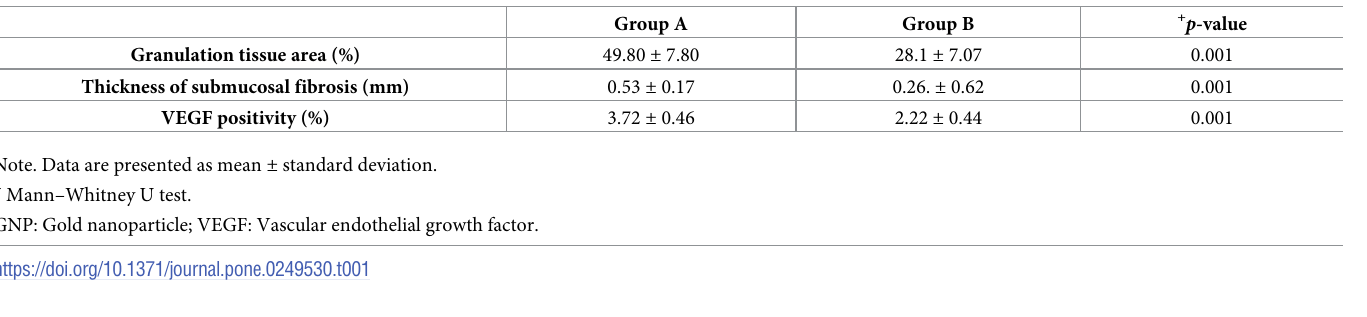
Table 1. Histological and immunohistochemical findings after GNP-coated stent placement with or without local heating.